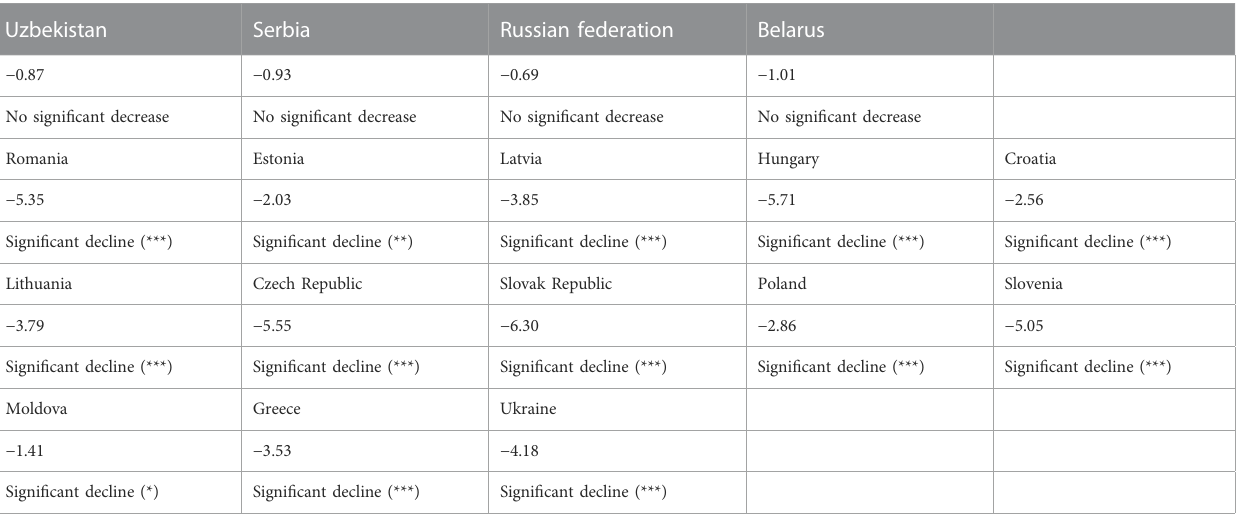
TABLE 2 M-K test of whether the downward trend is signi fi